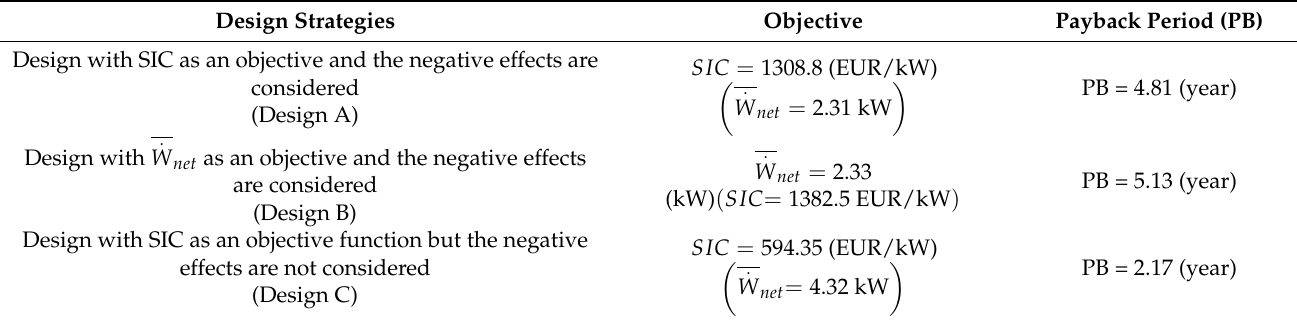
Table 14. The values of optimization functions for different design methods with